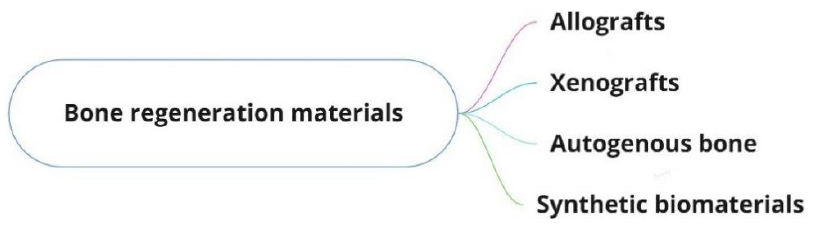
Figure 1. Flowchart of different bone regeneration biomaterials.